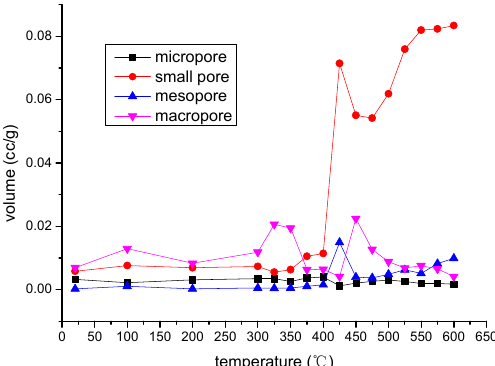
Figure 6. Pore volume of different size versus temperature of the first group samples.